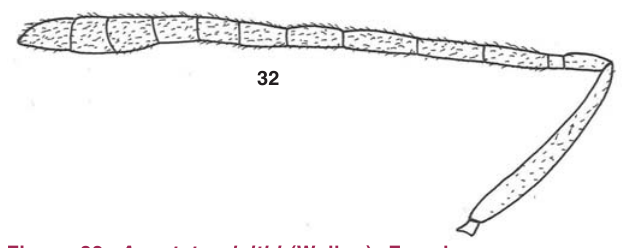
Figure 32. Anastatus leithi (Walker). Female 32 -